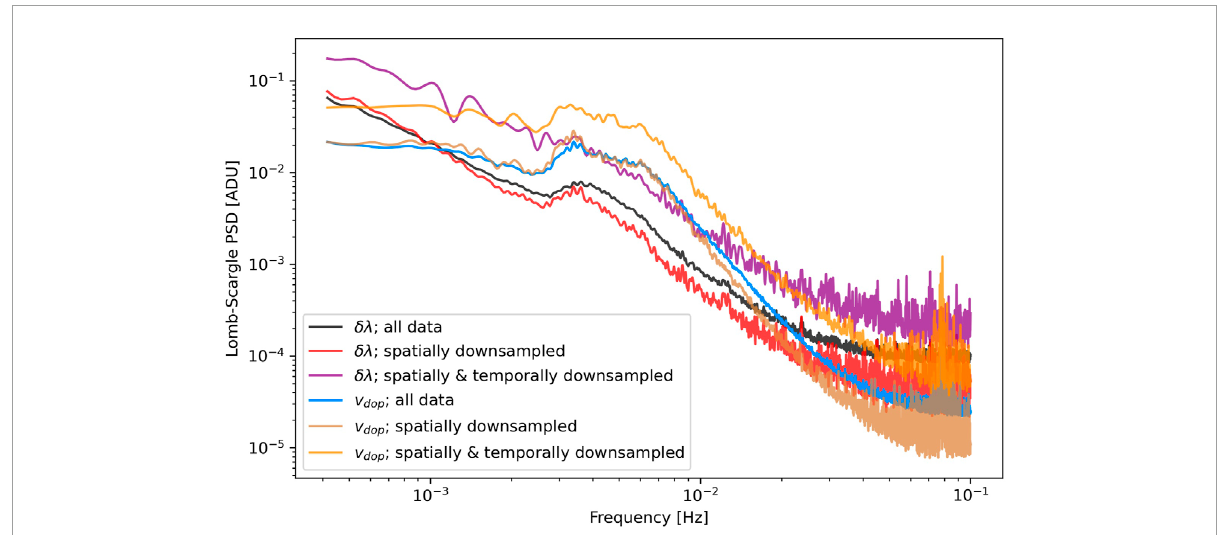
FIGURE 8 Spatially averaged power spectra of the IBIS Doppler velocity time series averaged over the full IBIS field of view for different spatial and temporal sampling schemes. The spectrum derived from the full data set is shown in blue, spatially down sampled in brown (which nearly overlaps the blue line below 10 mHz), and spatially-temporally down sampled in orange. The line width power spectra from Figure 7 are included for